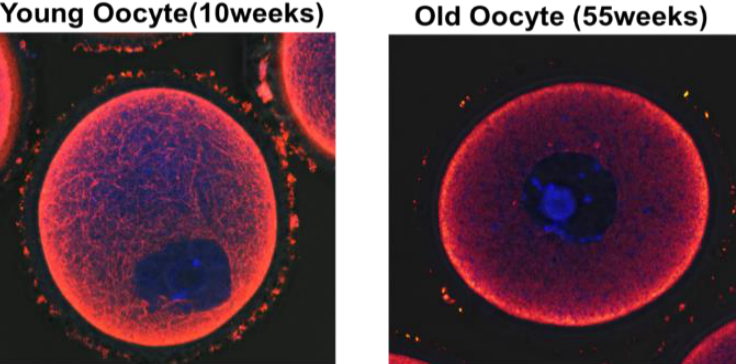
Figure 3. Immunocytochemistry fluorescence staining with anti-microtubule antibody (red) and nuclear count staining with Hoechst 33342 (blue) in the young (10 weeks) and old mouse oocyte (55 weeks).